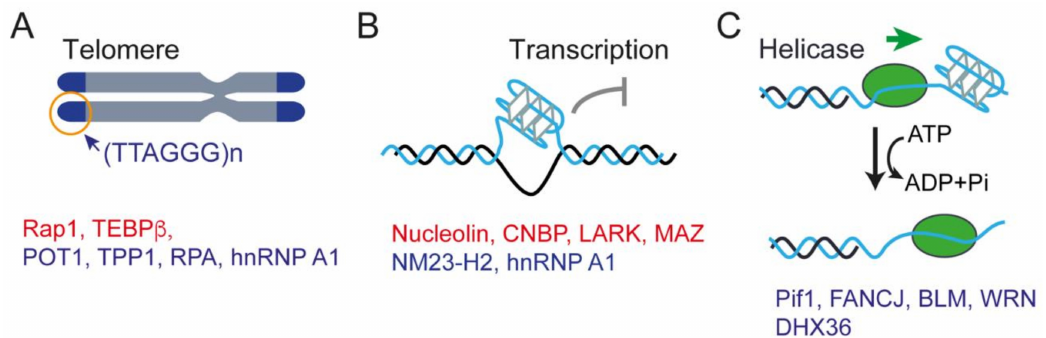
Figure 4. G4-interacting proteins. ( A ) Telomere and its associated proteins. ( B ) Transcription-related proteins. ( C ) Helicases. Proteins that promote G4s or stabilize G4s are shown in red. Proteins that unwind or destabilize G4s are shown in